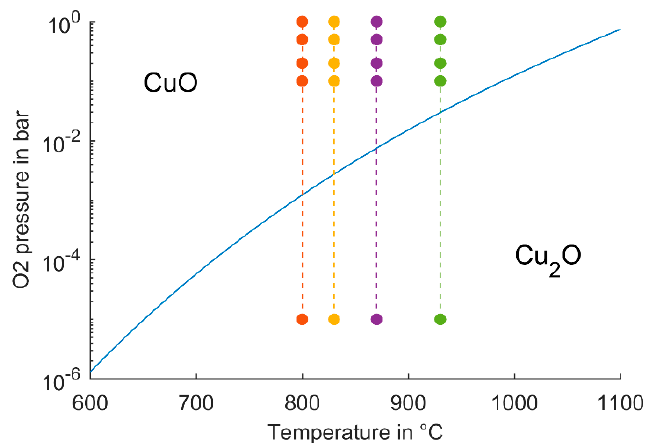
Figure 4. Representation of the operating conditions for the measurements relative to the equilibrium curve for the reaction system: Four temperature levels (800, 830, 870, 930 °C) and four partial oxygen partial pressures (0 bar for reduction, 0.1, 0.2, 0.5 and 1 bar for oxidation) at each temperature have been selected for the experiments.